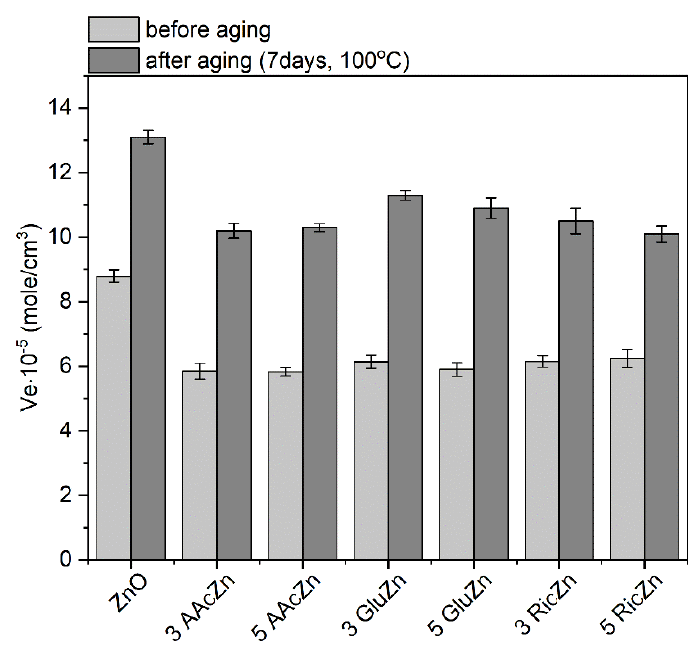
Figure 10. Effect of thermo-oxidative aging on the crosslink density of SBR vulcanizates with varying activators.